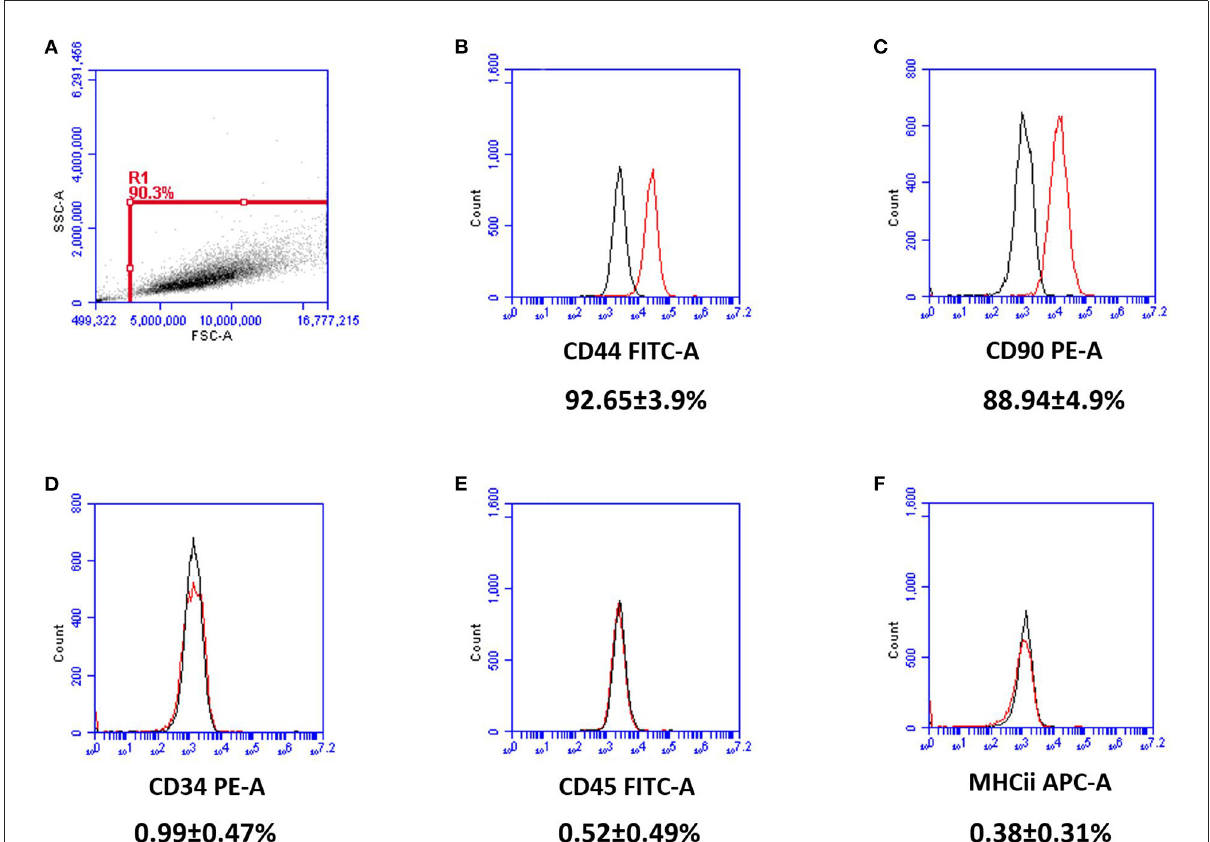
FIGURE2 Flow cytometry results for passage 2 canine MSCs ( n = 7). Cell surface markers were represented by the red histograms with isotope controls labeled black. Gating was set to R1 (A) . MSCs expressed CD44 (B) and CD90 (C) , while lacking expression of CD34 (D) , CD45 (E), and MHCii (F) . Percentages denote the intensity of positivity of the CD markers with standard